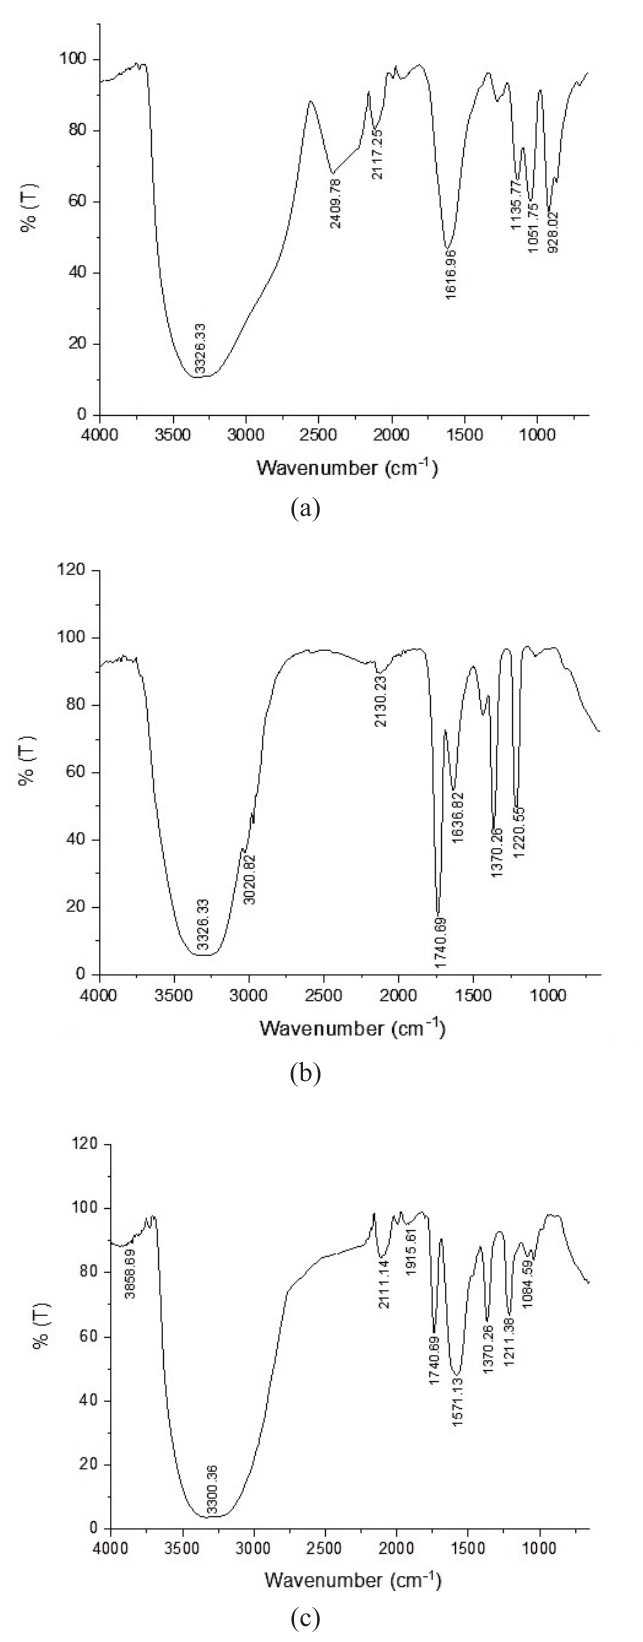
Fig. 3 – (a) FTIR spectra of activated carbon (before ad- sorption), (b) FTIR spectra of activated carbon (after adsorp- tion of Reactive Green 19), (c) FTIR spectra of activated car- bon (after adsorption of Reactive Red